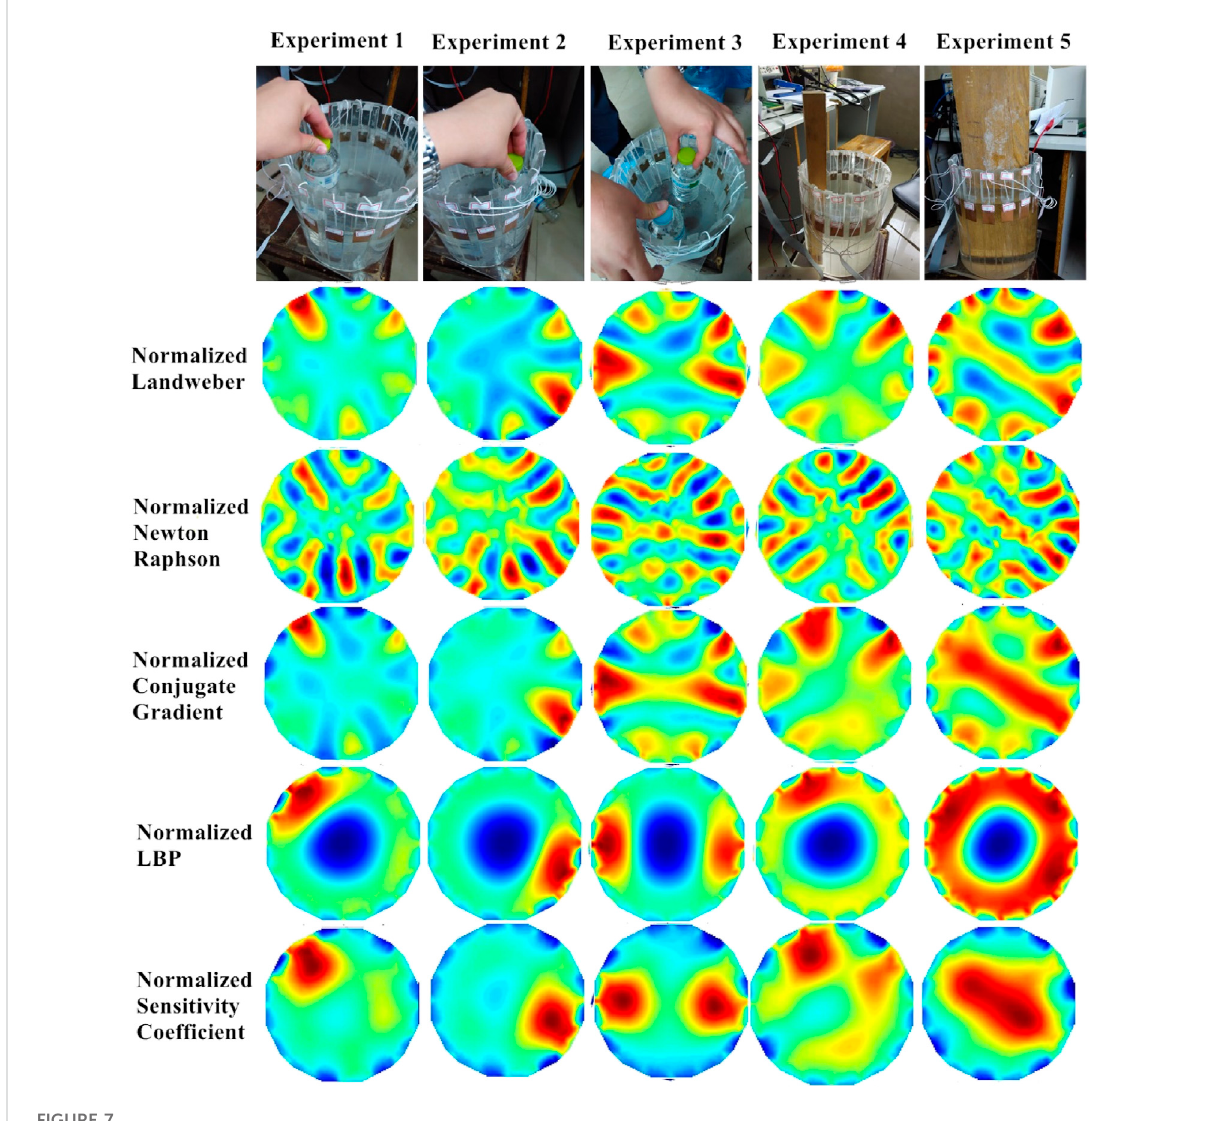
FIGURE 7 Reconstructed image of water body